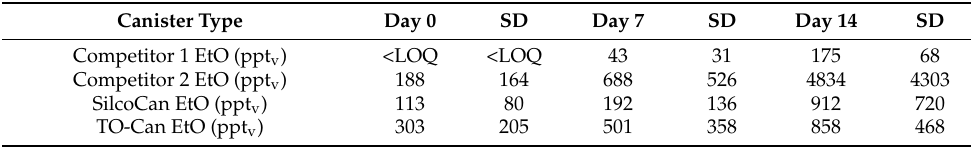
Figure 6. Ethylene Oxide growth over time. Average of 3 canisters for each data point, error bars are 1 standard deviation. Insert excludes Competitor 2.